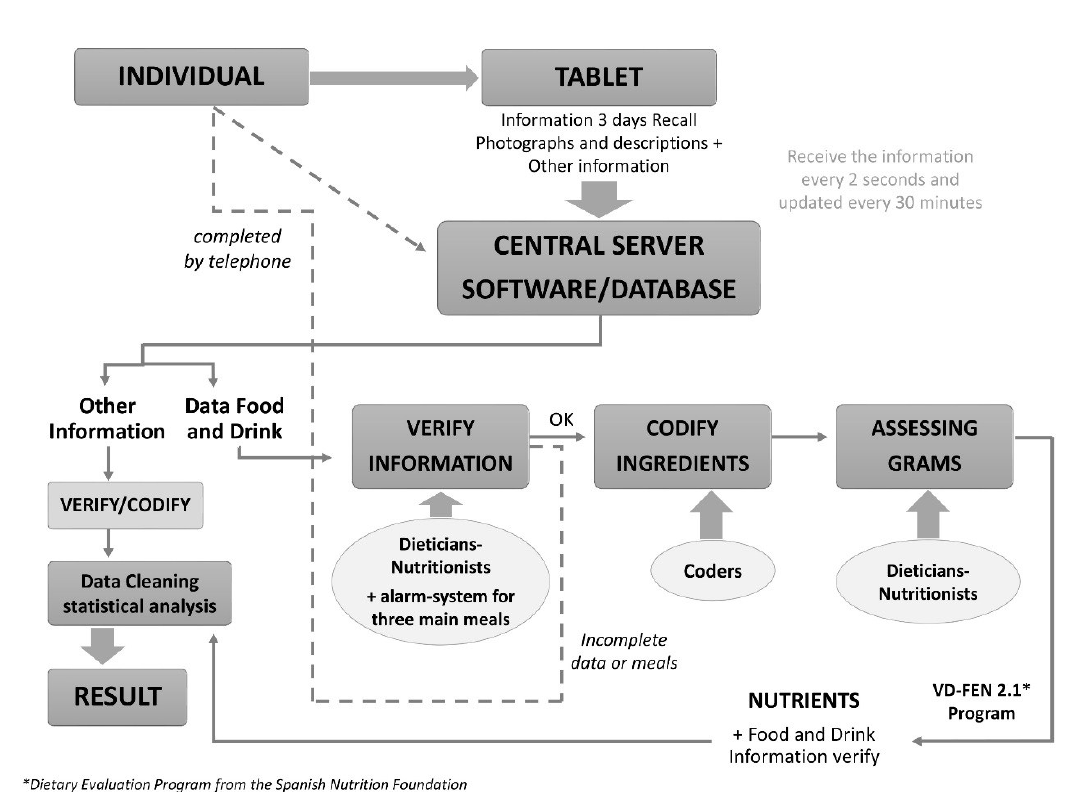
Figure 3. Main steps for codification and cleaning of data in the ANIBES Study. FEN= Spanish Nutrition